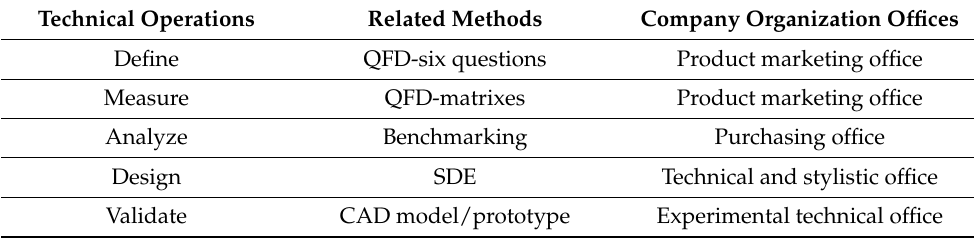
Table 2. Symmetry of DFSS: industrial engineering vs. management engineering. Technical